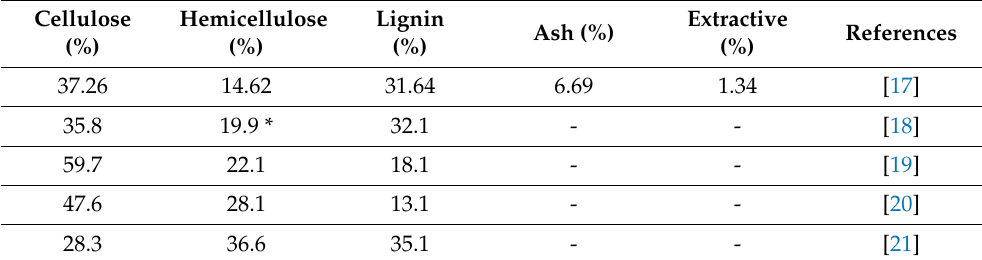
Table 1. Chemical composition of